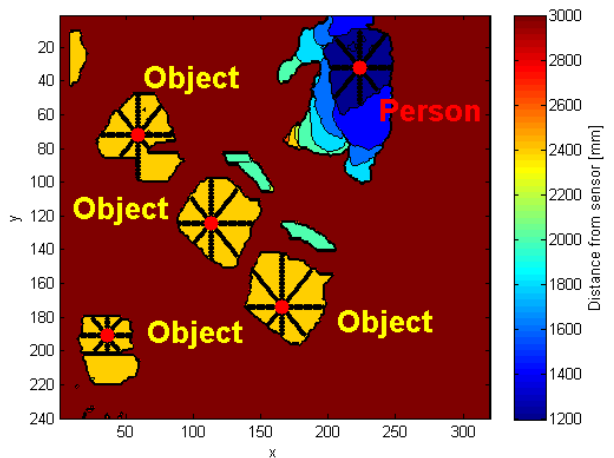
Figure 4. Research on the human subject in CF